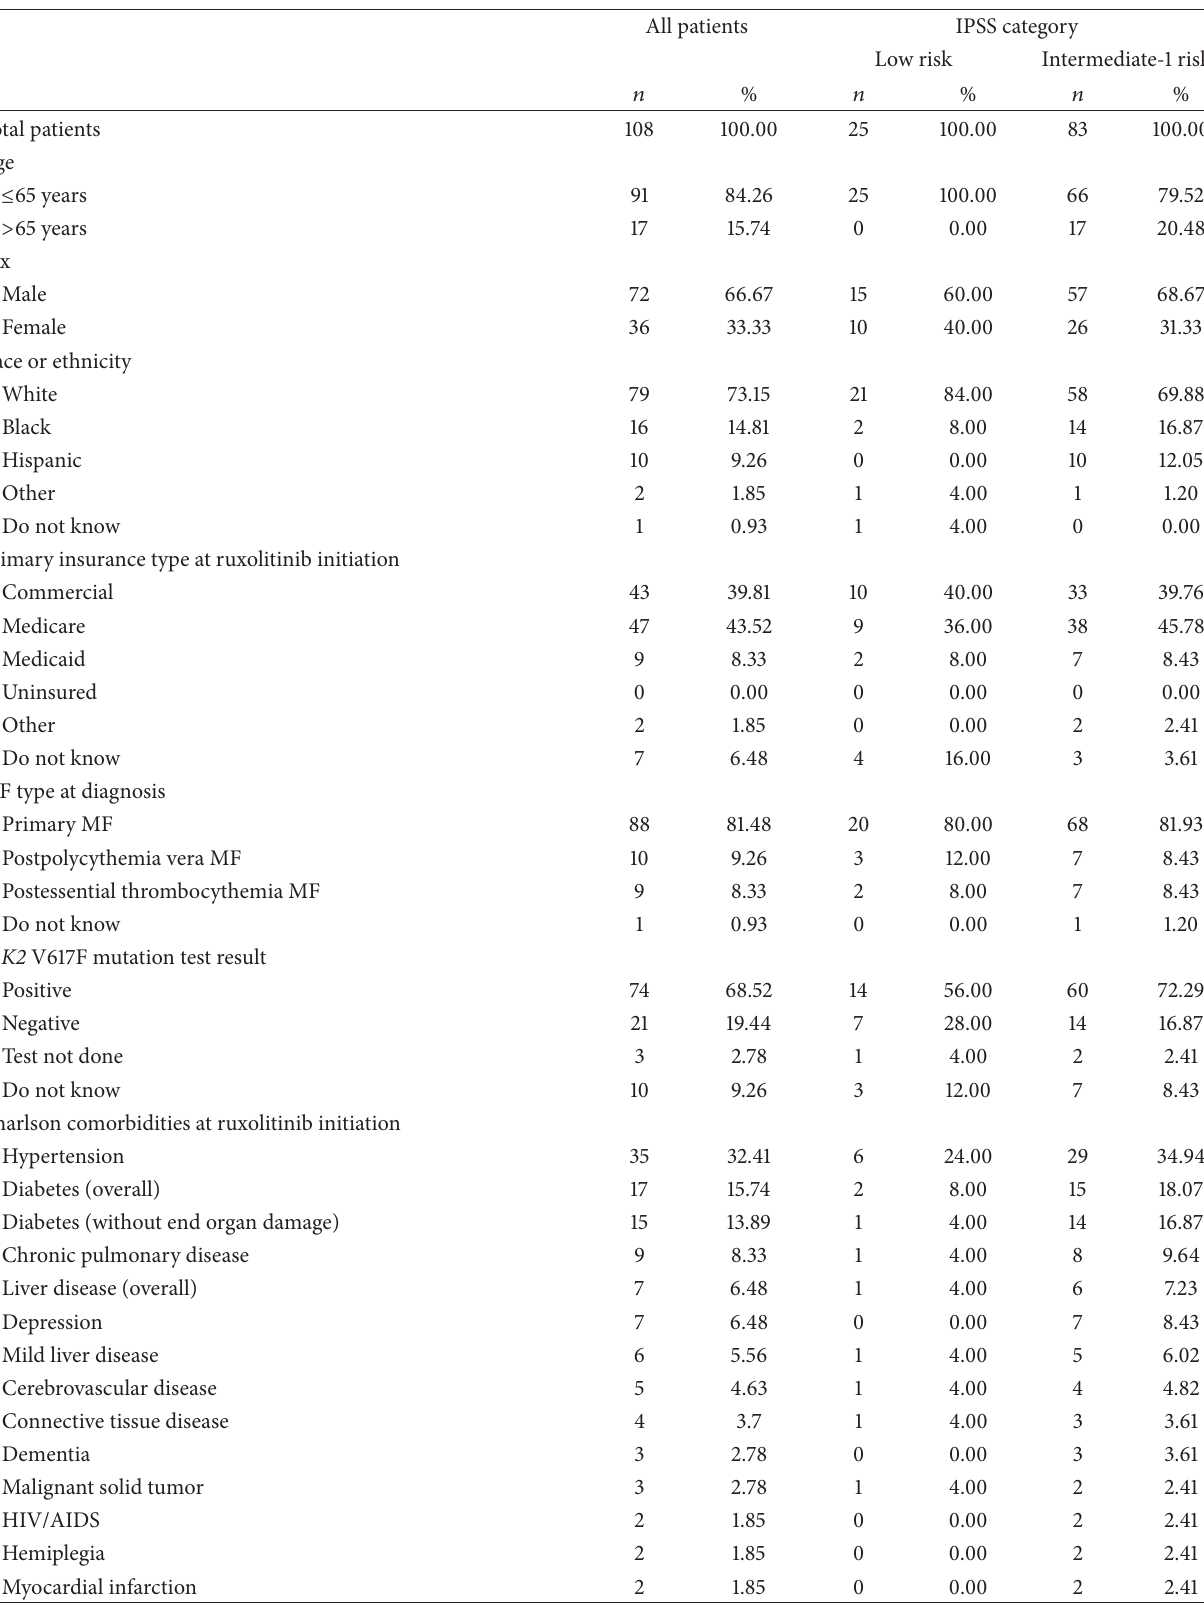
Table 2: Patient